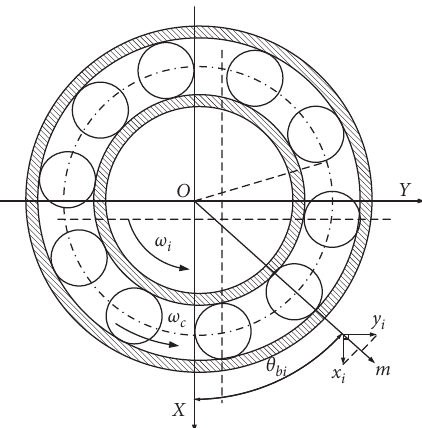
Figure 4: Deflection of bearing inner ring in X and Y